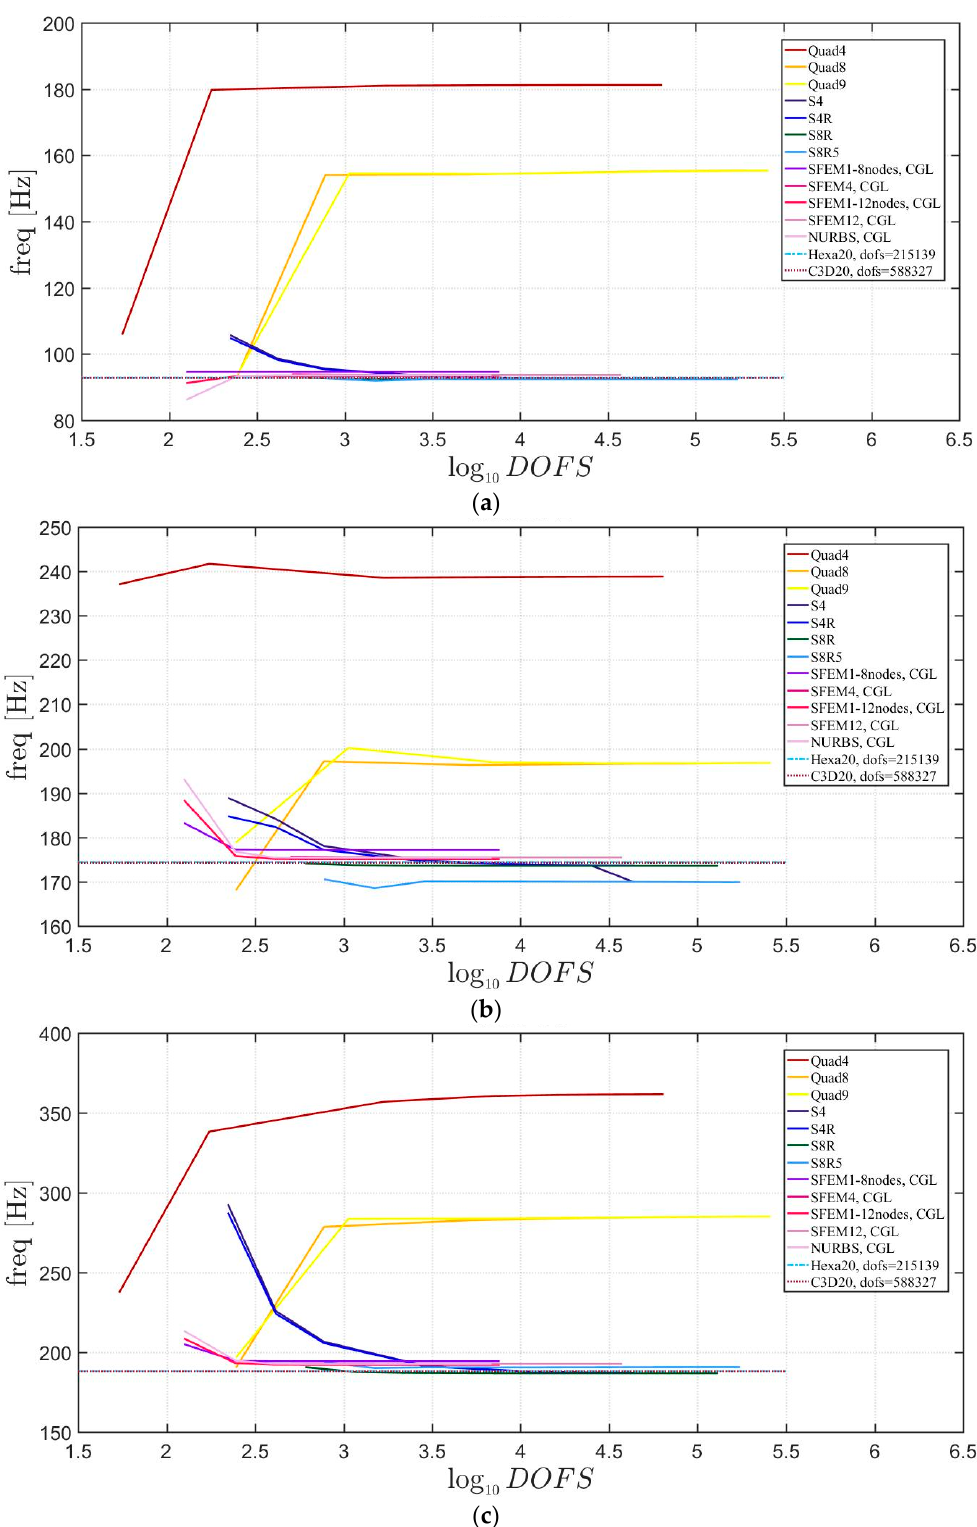
Figure 24. First three natural frequencies of an elliptic plate with a / b = 2 a symmetric lamination scheme and a / h = 10: ( a ) First frequency; ( b ) Second frequency; ( c ) Third frequency.